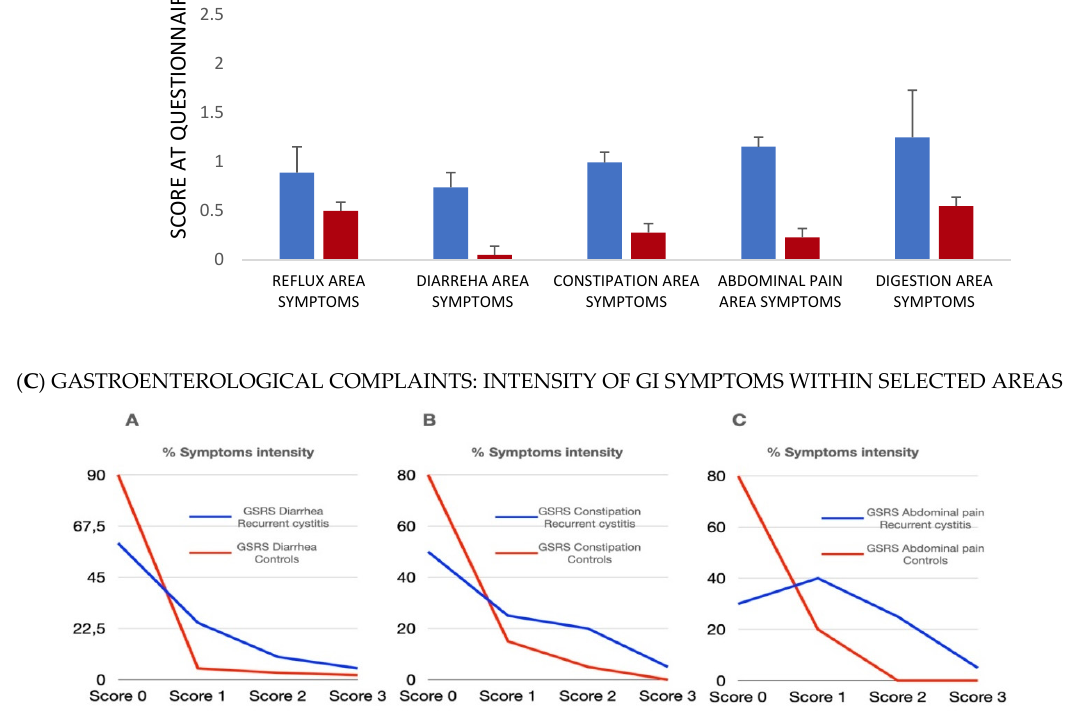
Figure 2. Gastroenterological complaints in RC patients (cohort I): Gastrointestinal Symptoms Rating Scale (GSRS) score. This questionnaire contains 15 questions related to five areas of interest in the gastroenterological clinic, concerning symptoms such as diarrhea, constipation, abdominal pain, reflux, dyspepsia. Among the enrolled patients, most showed an increased prevalence of all the items in the GSRS questionnaire. ( A ) Full GSRS score. ( B ) GSRS SCORE divided per gastrointestinal symptoms area score: reflux, diarrhea, constipation, abdominal pain, indigestion. ( C ) Intensity of symptoms according at GSRS for each single area: percentage of patients indicating a score of 3 (higher) or 2 or 1 or 0 (lower), respectively. Higher scores are consistent with increased severity of